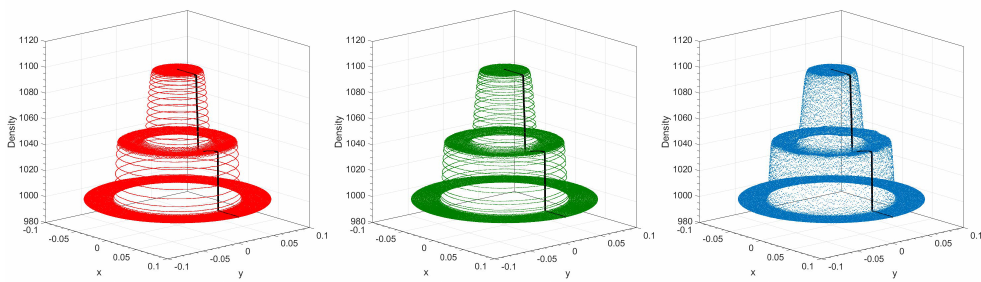
Figure 6. 2D Blast Explosion: Density plot in xy domain at time t final = 10 − 5 s. Radial distribution ( left ), Delaunay distribution ( center ), Random distribution ( right)